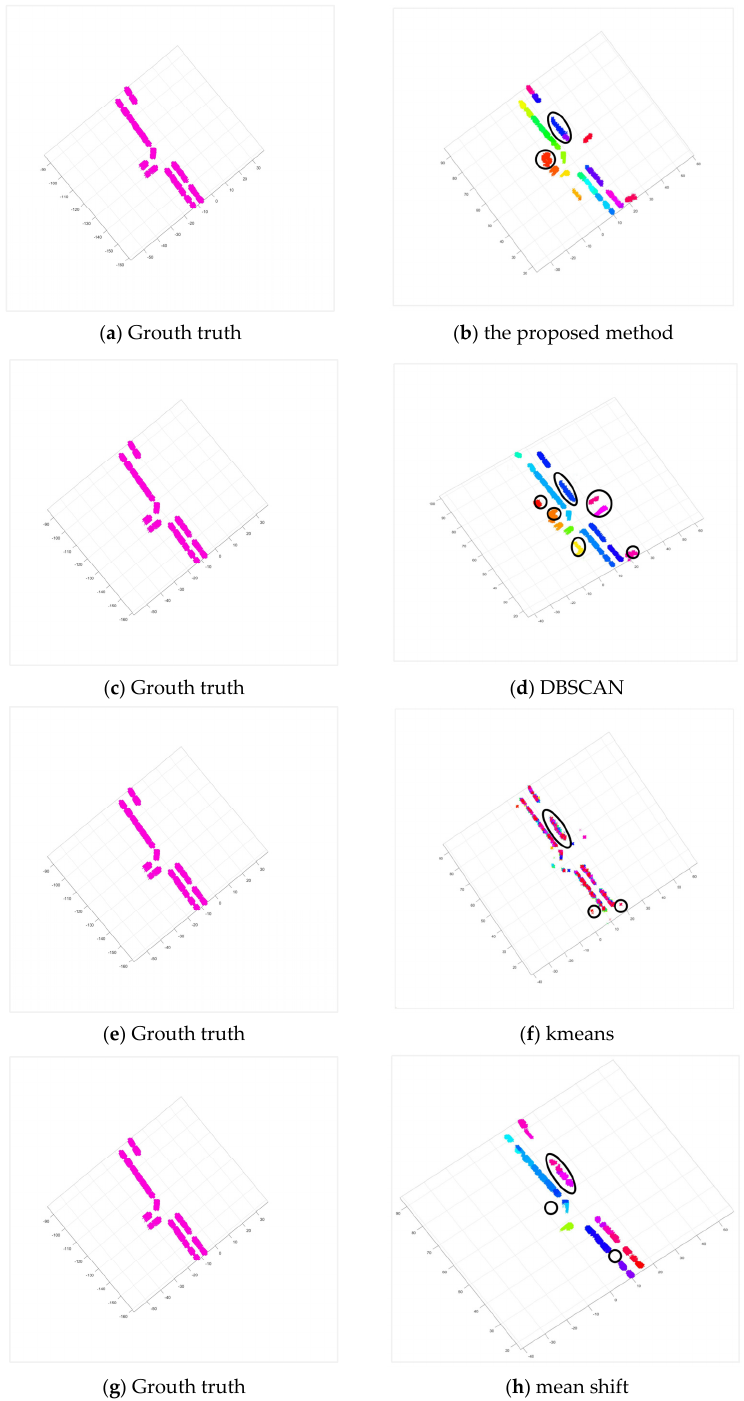
Figure 21. Side-by-side comparisons of neighborhood segmentation (( a , c , e , g ): Grouth truth; ( b ): the proposed method; ( d ): DBSCAN; ( f ): Kmeans; ( h ): mean shift). Note: Vehicles are distinguished by different colors ( a , c , e , g ); Different neighborhoods are displayed in different colors ( b , d , f , h ). Additionally, compared with the proposed method and mean shift algorithm, kmeans and DBSCAN algorithms are more prone to computation time problem when the number of point clouds is too large. The comparison of computation time is given in next section.